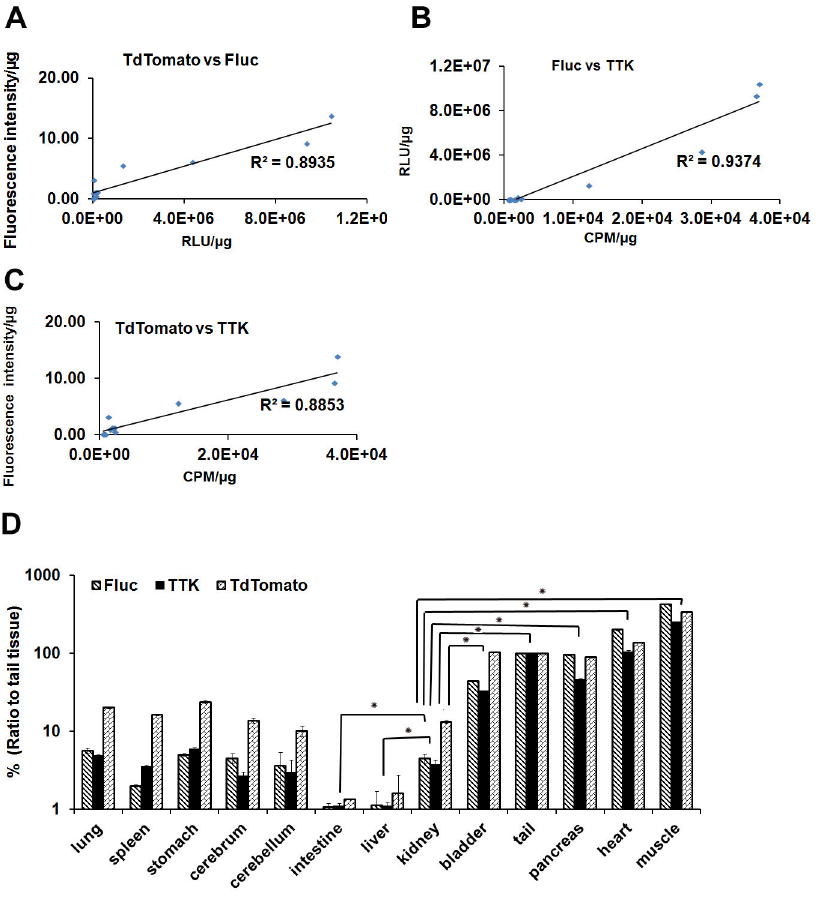
Figure 3. Reporter gene expression levels in transgenic mice and non-transgenic littermate. (A–C) In vitro luciferase assay, fluorescent assay and TK assay were performed with cell lysates from the tail of transgenic mice. Correlation of Fluc, tdTomato and TTK gene expression levels in transgenic mice and non-transgenic littermate (n=15). (D) Reporter gene expression levels in various organs from transgenic mice. Transgenic mice with high expression level of reporter gene were harvested and tested using in vitro assays. Muscle, heart, tail, pancreas and bladder have statistically higher expression (P<0.05) of reporter gene than kidney, while the liver and intestine have lower expression (P<0.05) (*indicates p<0.05). RLU = relative light units; cpm=counts per minute; FI = Fluorescence